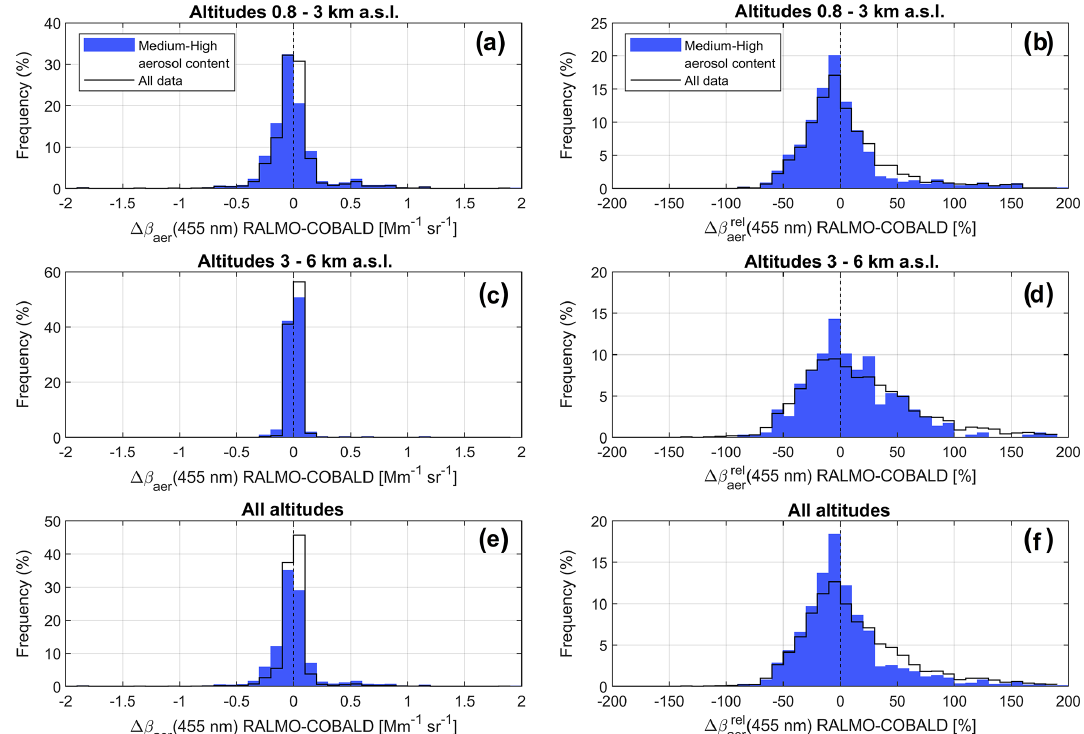
Figure 6. Statistical comparison of RALMO vs. COBALD: frequency-of-occurrence distributions of medium-high-aerosol-content data (blue bars) and all data (black lines). Panels (a, c, e) : frequency-of-occurrence distributions of the RALMO − COBALD difference in aerosol backscatter coefficient ( (cid:49)β aer ) at 455nm for the altitude intervals 0.8–3kma.s.l. (a) , 3–6kma.s.l. (c) and 0.8–6kma.s.l. (i.e., all altitudes: panel e ). Panels (b, d, f) : same as panels (a, c, e) , with (cid:49)β aer expressed in percent units (%) relative to the COBALD measurements (i.e., (cid:49)β rel aer ). The frequency-of-occurrence distributions are calculated in (cid:49)β aer intervals of 0.1Mm − 1 sr − 1 (a, c, e) and 10% (a, c, e) . Table 2. Statistical comparison of RALMO vs. COBALD: results for medium-high aerosol content. For each altitude interval, we show mean deviation (in both absolute units, δ , and percent units relative to COBALD, δ rel ) and standard deviation (in both absolute units, σ , and percent units relative to COBALD, σ rel ) at 455nm as well as Pearson correlation coefficient ( ρ ). RALMO − COBALD (17 profiles, 2016–2019, medium-high aerosol content) Altitude interval Mean deviation, δ(δ rel